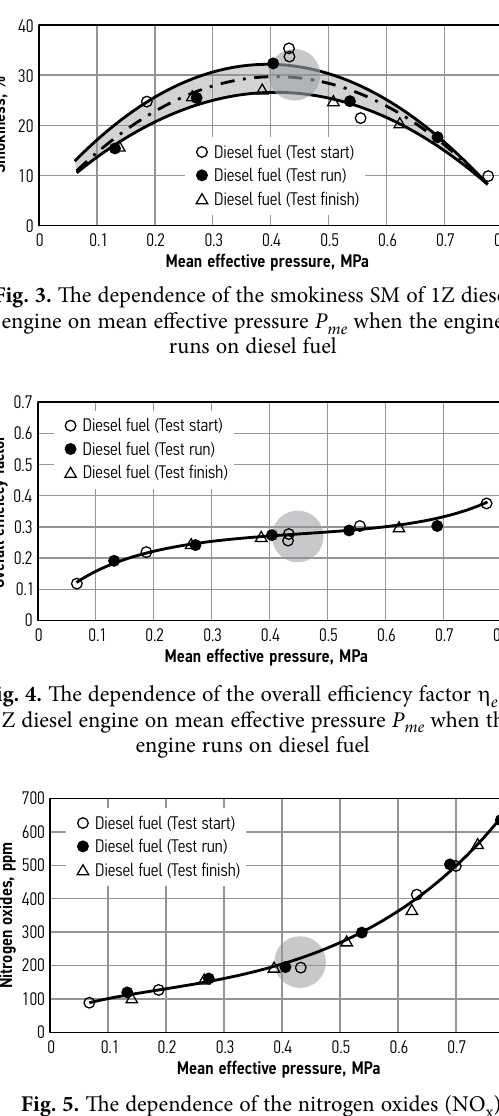
Fig. 2. The dependence of the excess-air ratio λ of 1Z diesel engine on mean effective pressure P me when the engine runs on diesel fuel